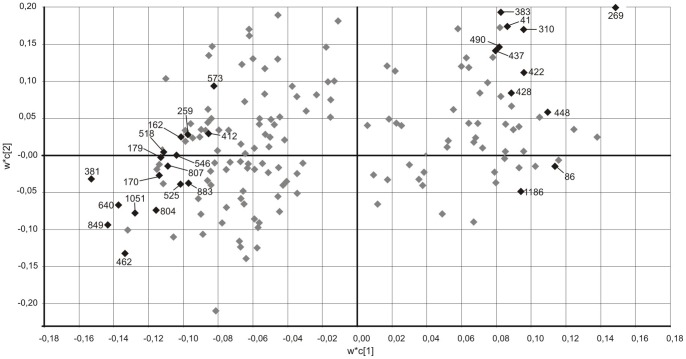
PLS-DA weight plot.Weight plot (w*c[1]/w*c[2]) from the PLS-DA model of healthy and myalgic muscle based on 170 protein spots. Situated on the left in the figure are proteins with a higher abundance in the myalgic muscle and on the right, proteins with a higher abundance in healthy muscle. Analyzed spots (◊) with variable of importance values (VIP)<1.